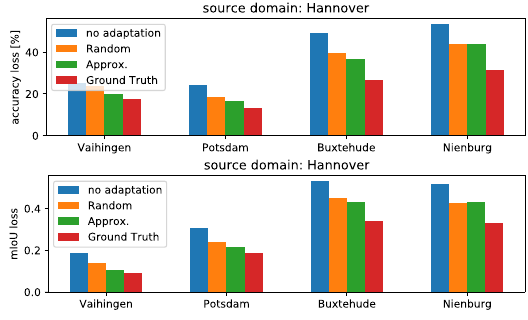
Table 4. Per-class IoU improvements for different mapping strategies compared against the random mapping strategy (DANN-like domain adaptation from Hannover to Vaihingen)